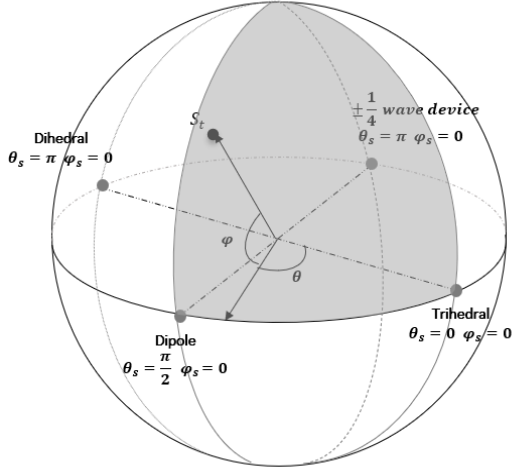
Figure 5. The new spherical topology constructed based on the complementary nature of elementary scattering